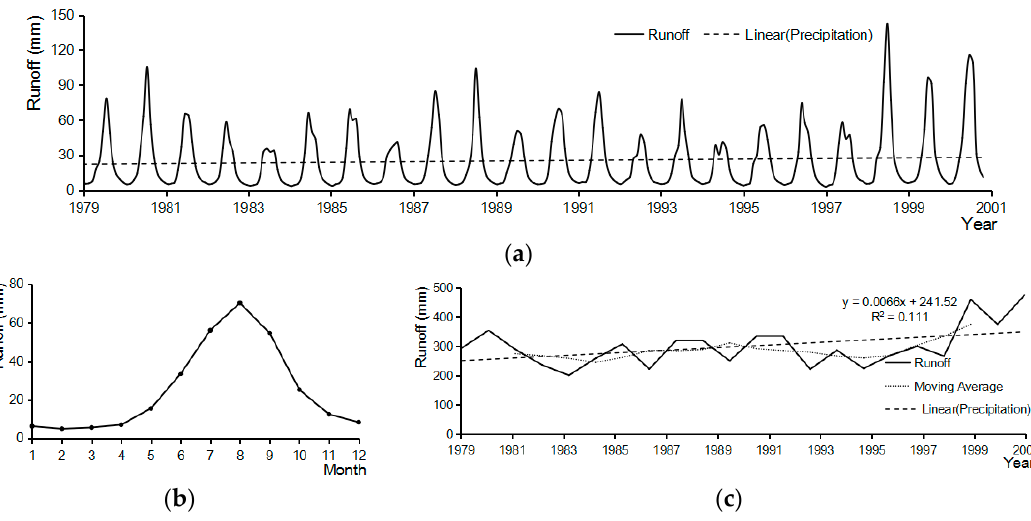
Figure 5. Characteristics of observed runoff change for Nuxia gauging station. ( a ) Time series of monthly runoff; ( b ) The secular mean monthly runoff; and, ( c ) The mean annual runoff.